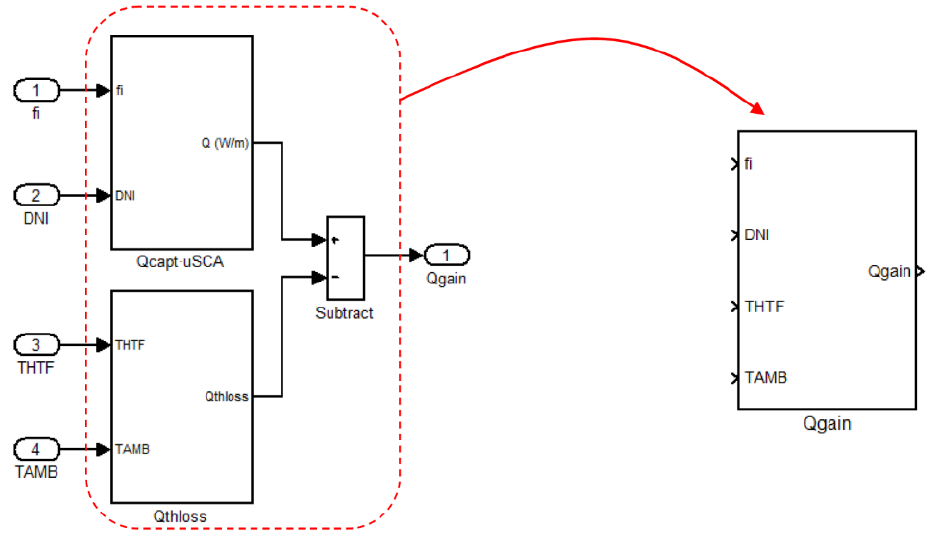
Figure 11. Simulink block model to calculate (cid:1843)(cid:4662) (cid:2917)(cid:2911)(cid:2919)(cid:2924) .